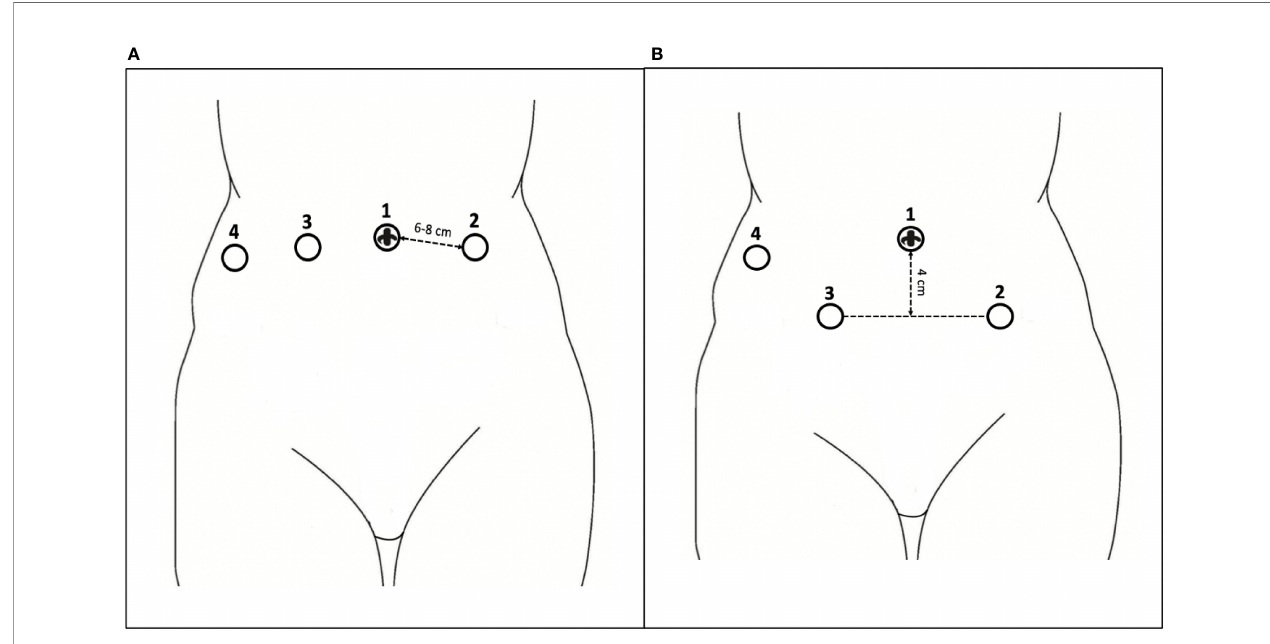
FIGURE 5 | (A) The “ straight ” port placement; (B) The “ bridge ” port placement.